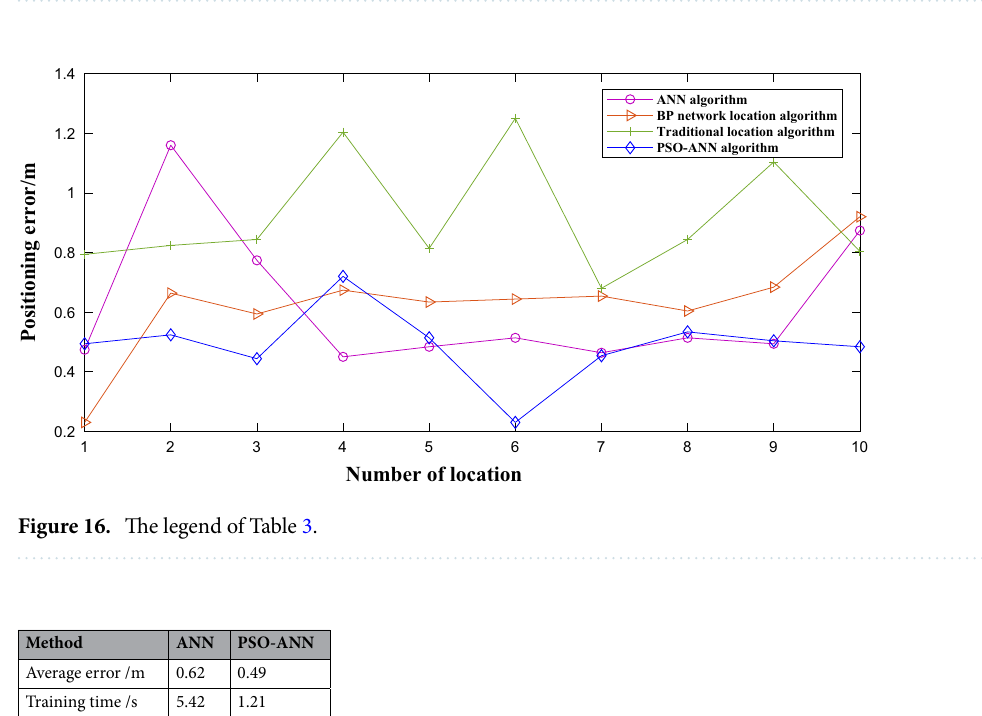
Table 3. Comparison of location results of the four algorithms.